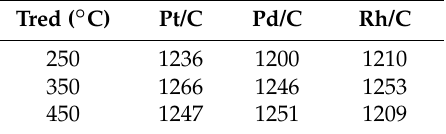
Table 1. BET surface area (m 2 · g − 1 ) of the catalysts reduced at different